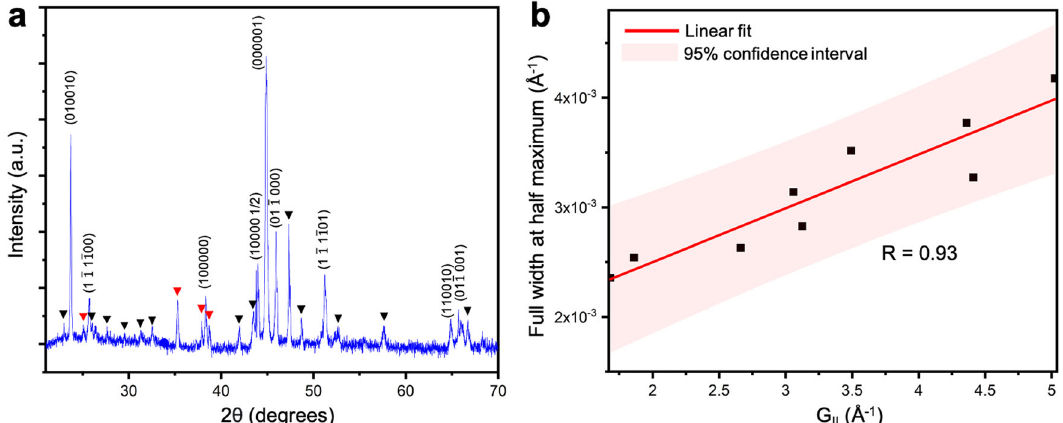
Fig. 2 X-ray diffraction analysis. a X-ray diffraction pattern of water-quenched Al 79 Co 6 Ni 15 alloy from an initial temperature of 1030 °C. Rapid quenching prevents peritectic transformation of d-QCs from proceeding to completion. The diffraction peaks are indexed to con fi rm the presence of decagonal (d-) QCs at 970 °C. The peaks indexed with black and red correspond to the Al 3 Ni and aluminum oxide, respectively. b A linear fi t with Pearson correlation coef fi cient of 0.93 is shown between G ∥ and FWHM along with 95% con fi dence interval bounds, see text for aperiodic plane regardless of the initial distance between them. d-QC on the left-hand-side in Fig. 1(b) between 40 and 50 min of Our quantitative analysis of facet orientations as a function of cooling (i.e., prior to collision) can be attributed to a mutual time (Supplementary Fig. 1) provides further support of this interference of diffusion fi elds between the two grains. behavior. The groove itself does not move laterally along the On the other hand, in the case where the two long axes are solid – liquid interfaces on the intermediate time-scales (see arrow non-parallel to each other, we observed the persistence of a in Fig. 1(b)), which would indicate that GB translation on its own V-shaped GB groove (Fig. 1(d, e)), signifying the formation of a is not the mechanism of coalescence. The irregular shape of the stable GB between the two grains. In comparison to the above